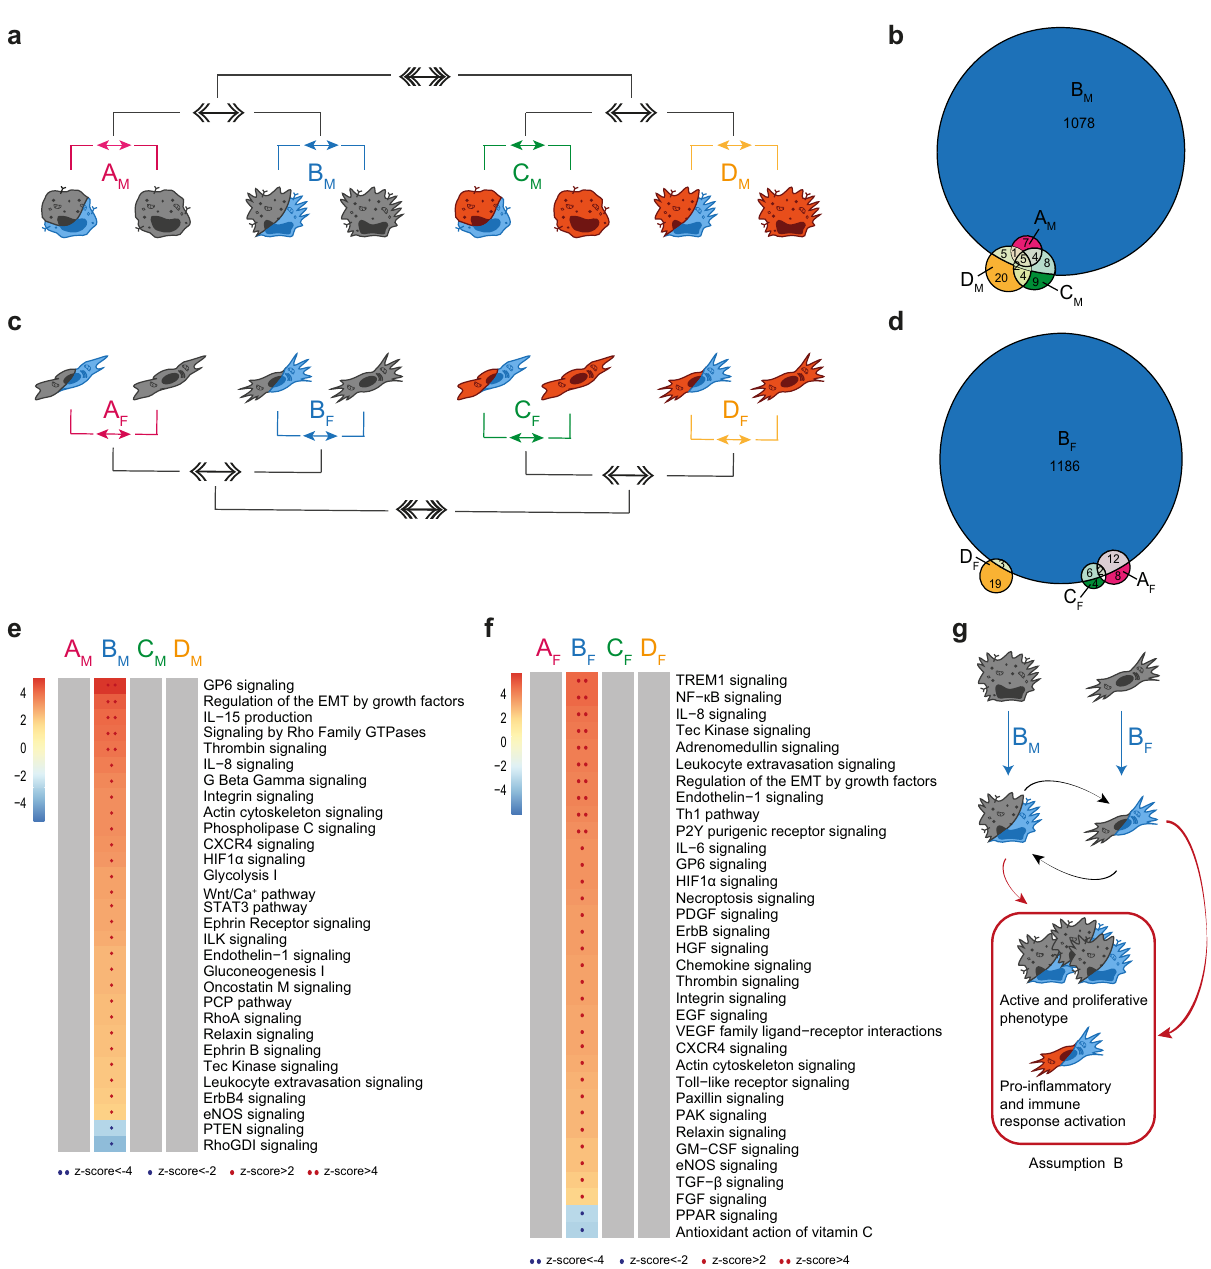
level comparison in M φ ( b )and Fb( d ). e , f Pathways enrichmentanalysis in M φ ( e ) andFb( f )comparisons.Columnsrepresent1stlevelanalysis(A-B-C-D),rowsreport pathways signi fi cantly modulated (|z-score| ≥ 2) in at least one comparison.